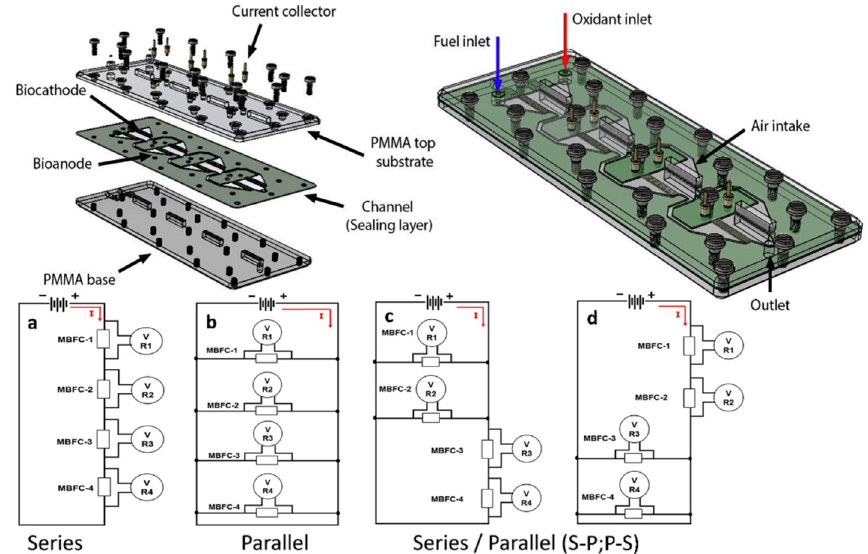
Figure 6. A schematic illustration of the micro-EFC stack realized by the integration of four individual cells and diagrams of the investigated cell connections. Configuration ( a ) corresponds to series connection of the cells, ( b ) to parallel connection, ( c ) and ( d ) to a mix of series and parallel electrical connections [44].